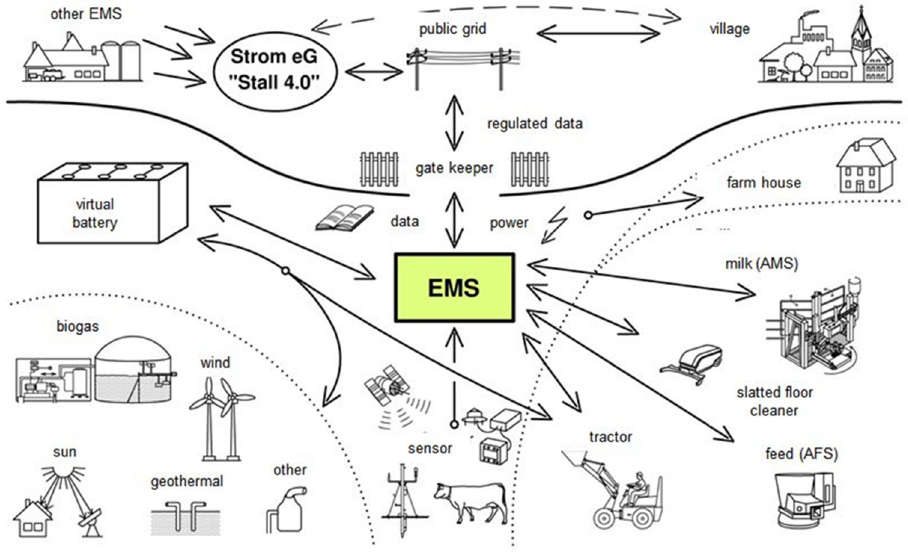
Figure 1. Energy management system.